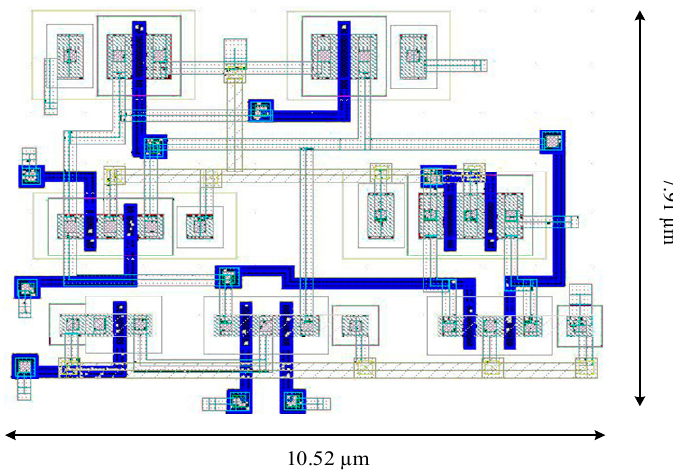
Figure 6. The layout of the proposed Schmitt trigger in 0.18 μ m CMOS technology.